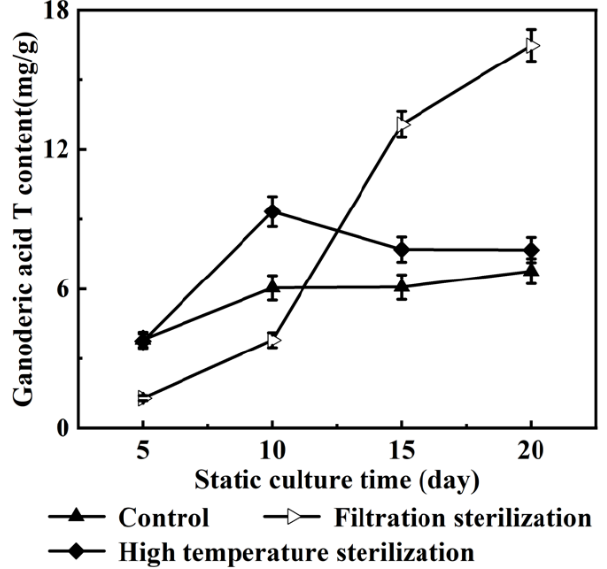
Figure 1. Substrate and product contents of G. lucidum submerged fermentation-static culture under different oleic acid addition methods.